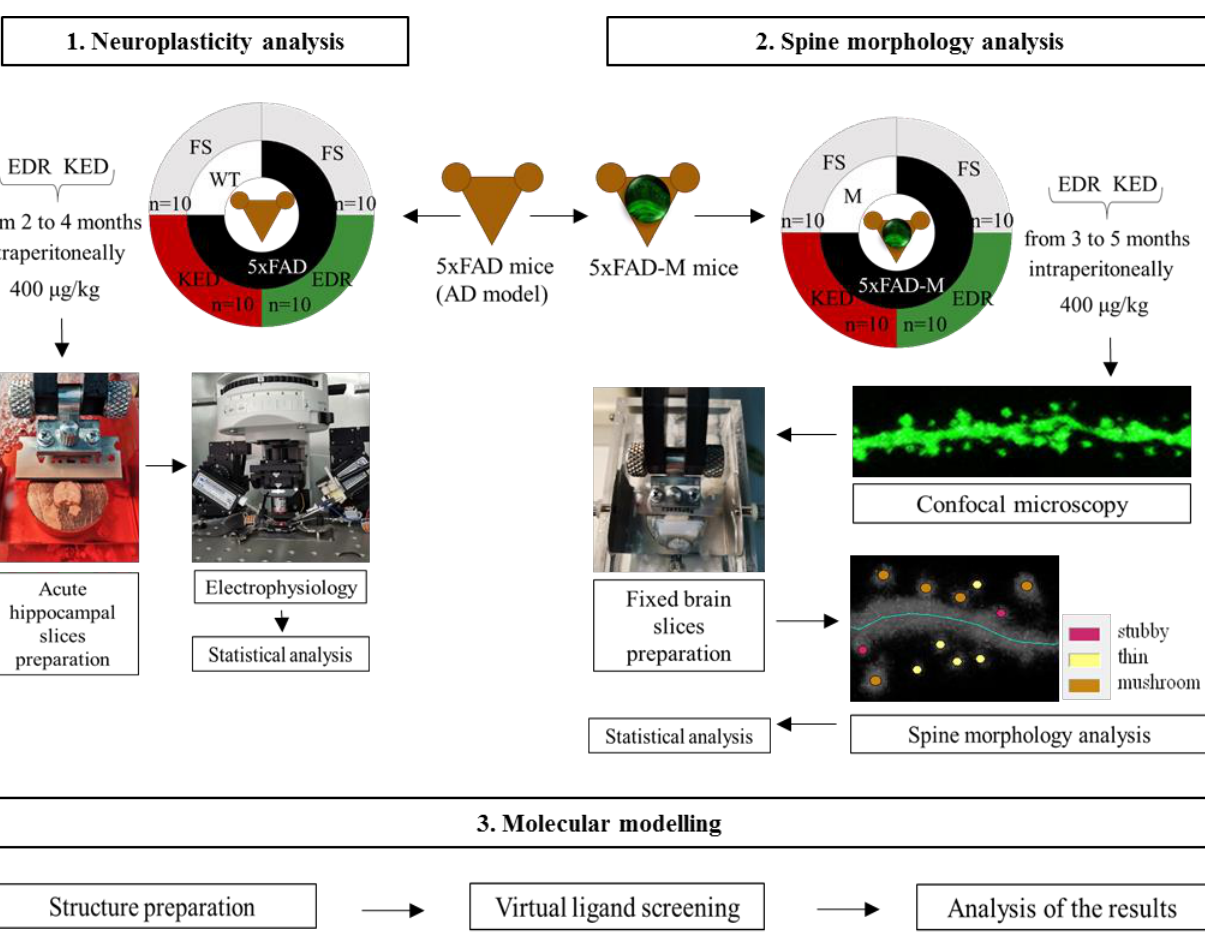
Figure 13. Experimental schedule. Note: FS—physiological solution.